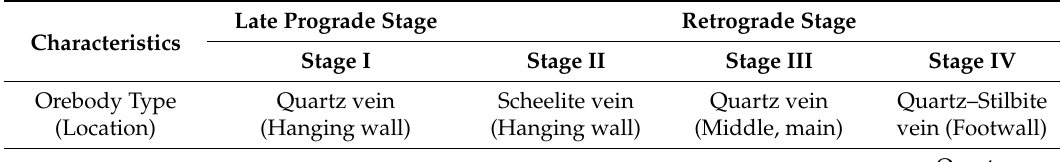
Table 4. Summarized table of mineralogical occurrence of each quartz–scheelite vein